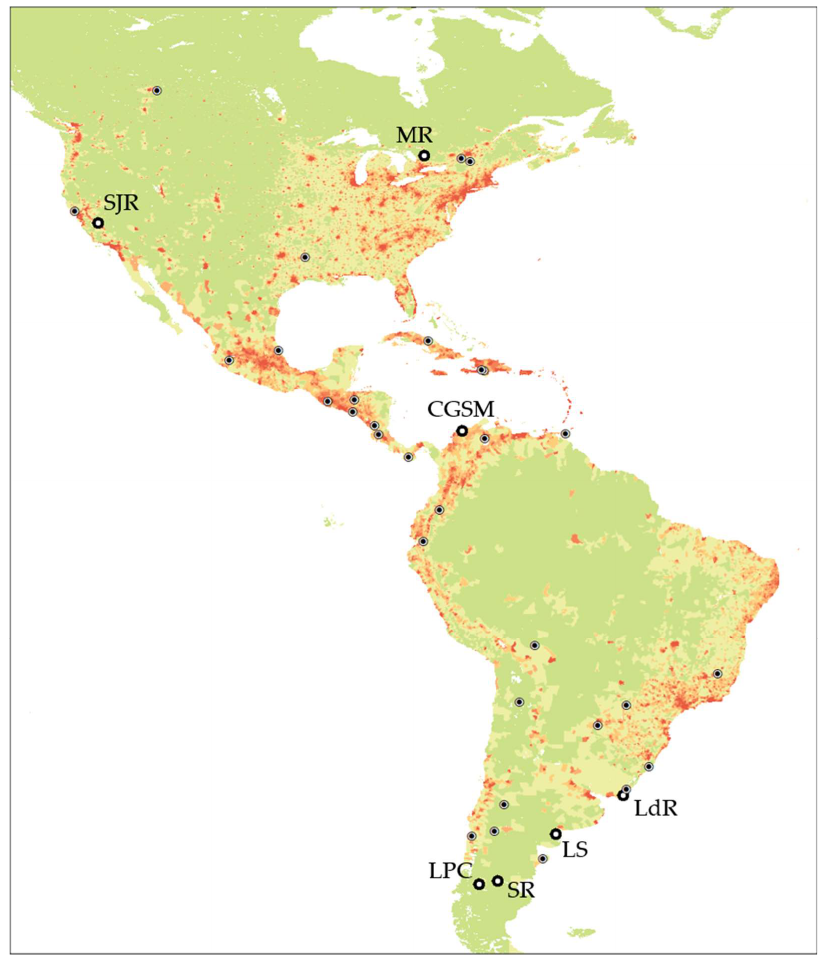
Figure 1. Map showing estimated human population density [30] and the locations of Ramsar sites (black-in-white circles) and SAFER project sites (white-in-black circles) used in this study (see Ramsar site list in Table A1; see SAFER abbreviations in Table 1). Table 1. Current project (SAFER) study sites, priority freshwater ecosystem services, and major threats.